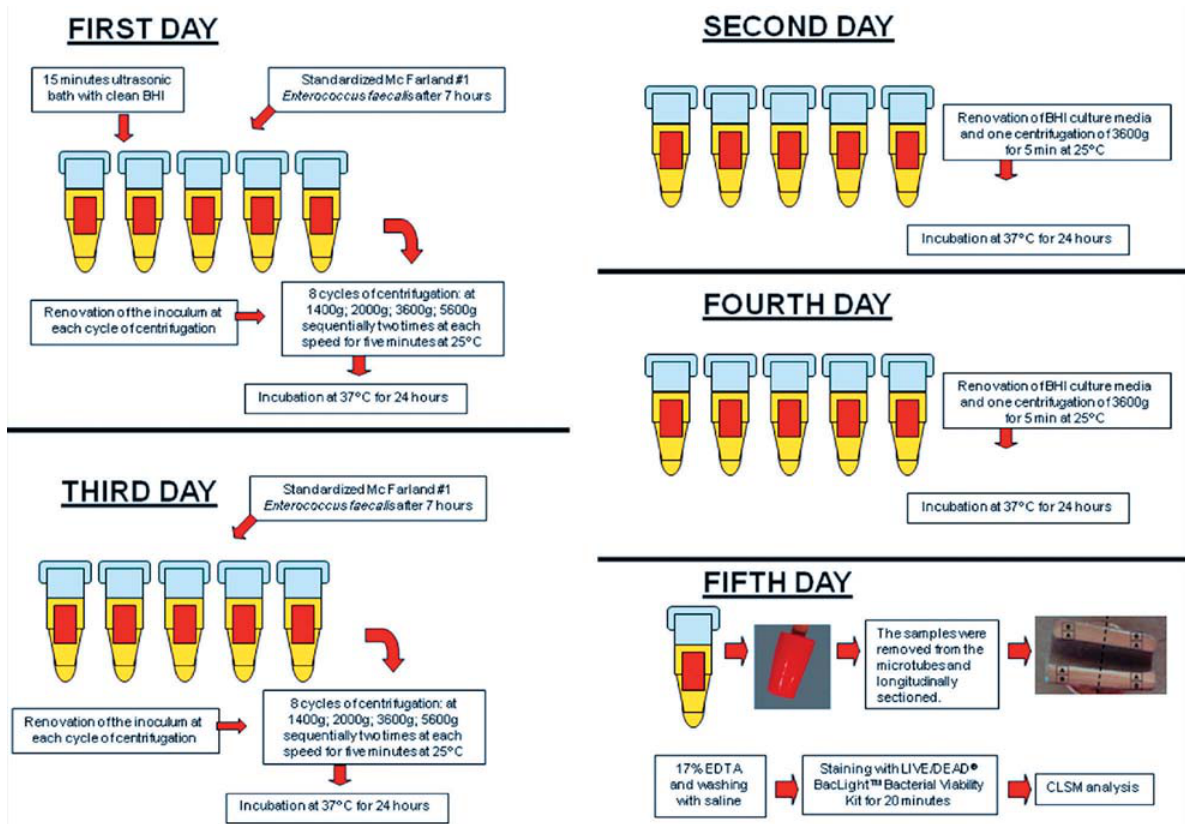
Figure 1- Flowchart of the group C contamination